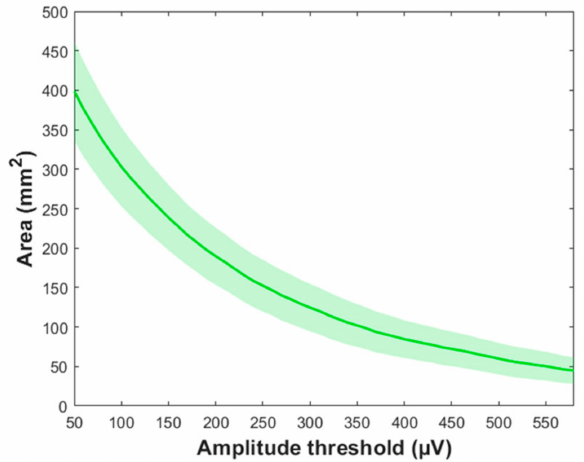
Figure 13. Effect of amplitude criterion for accepted MEPs measured on the resulting motor map size as determined using spline interpolation [27]. In the figure, 24 cortical mapping experiments for locating and outlining the FDI muscle representation were used to calculate the mean ( green line ) and 95% confidence interval ( green area ) for the motor area at different amplitude threshold criteria for accepted